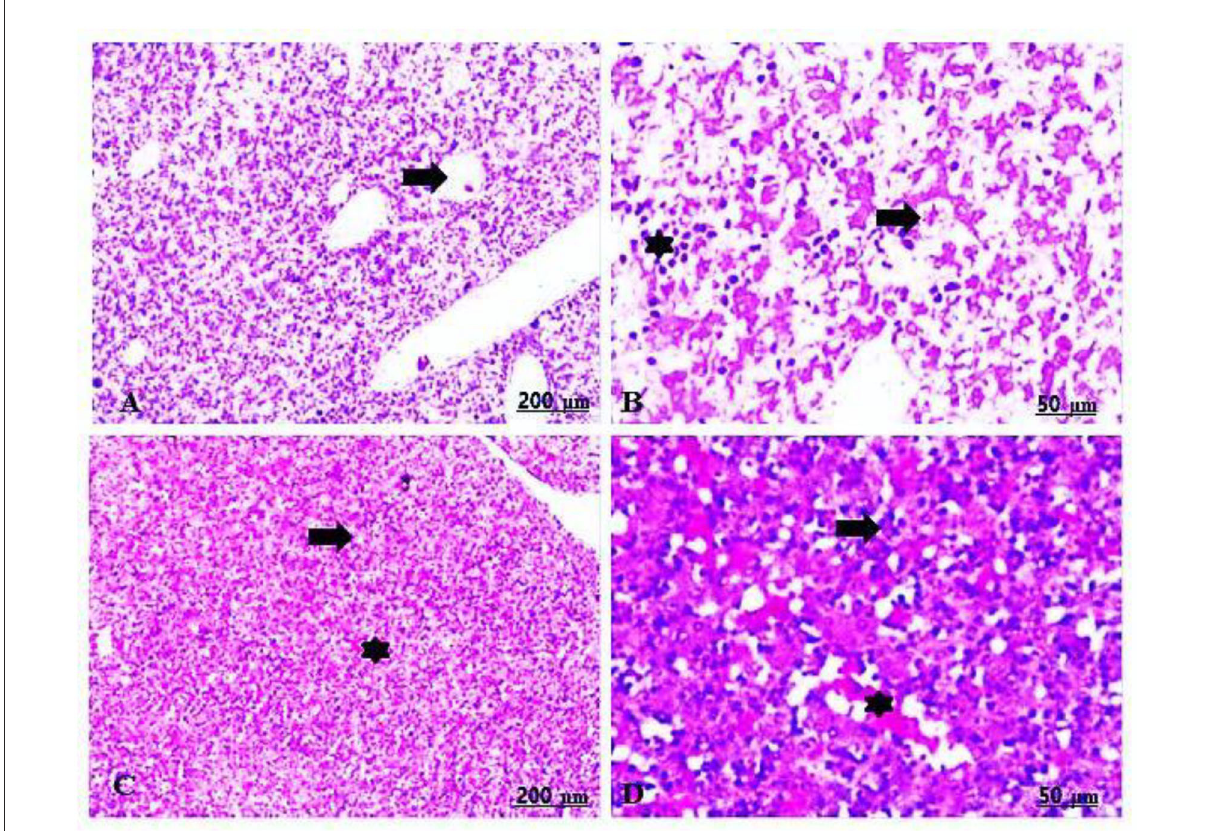
FIGURE5 (A–D) Light photomicrograph of sections from the fetal liver of GTiO 2 NPs exposed groups. GTiO 2 NPs of 100 mg/kg bwt show slight congestion and dilatation of the central vein (A) , in addition to cytoplasmic vacuolation (arrow) and inflammatory cell infiltration (star) (B) . GTiO 2 NPs of 300 mg/kg bwt show proliferation of the hepatocytes with mitotic division (arrow) in addition to congestion and dilatation of the blood vessels (star) (C,D) .